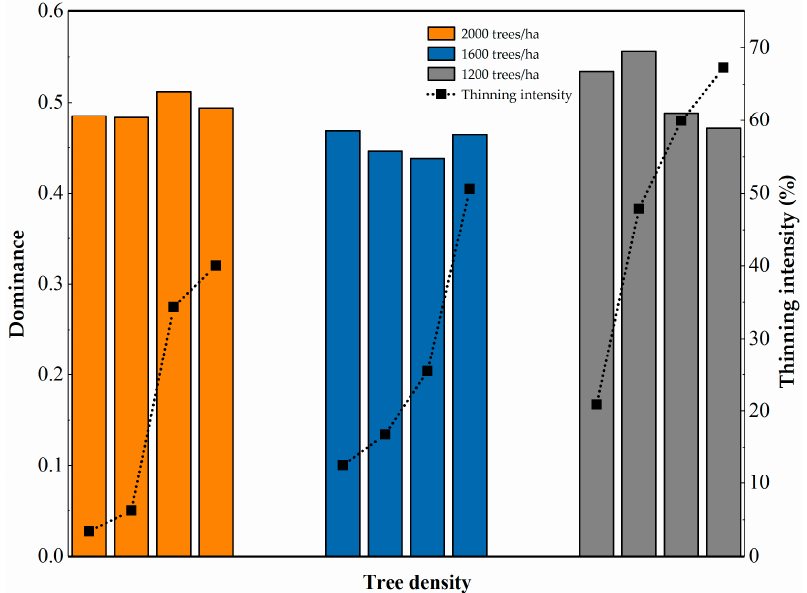
Figure 3. The effect of thinning on dominance under different stand density.